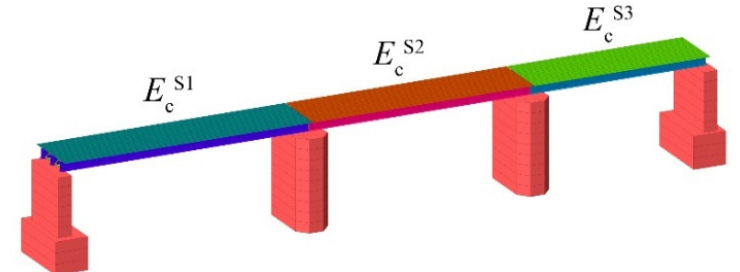
Figure 11. FE model of Baghetto Bridge with the updated parameters indicated.